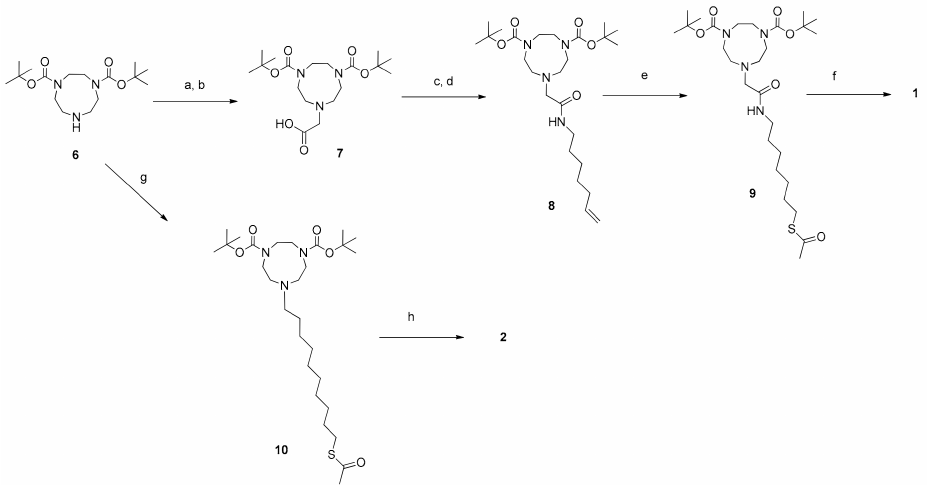
Scheme 1. Synthetic route to thiols 1 and 2. a: 2-Br-methylacetate, Cs 2 CO 3 in ACN(dry), N 2